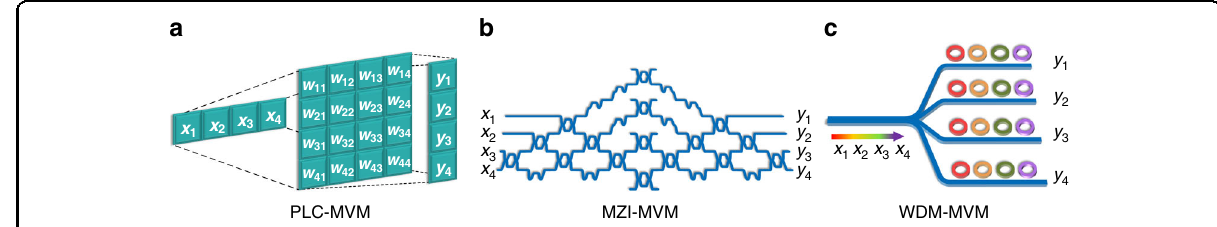
Fig. 1 Methods for matrix multiplication computation. a PLC-MVM. b MZI-MVM. c